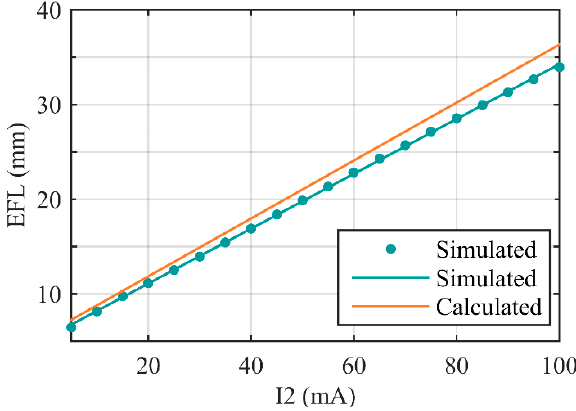
Figure 5. Calculated and simulated EFL as functions of I 2 . The “simulated dots” mark the EFL of sampling points that be obtained by CODE V. The “simulated line” is the fitting curve of the dots.